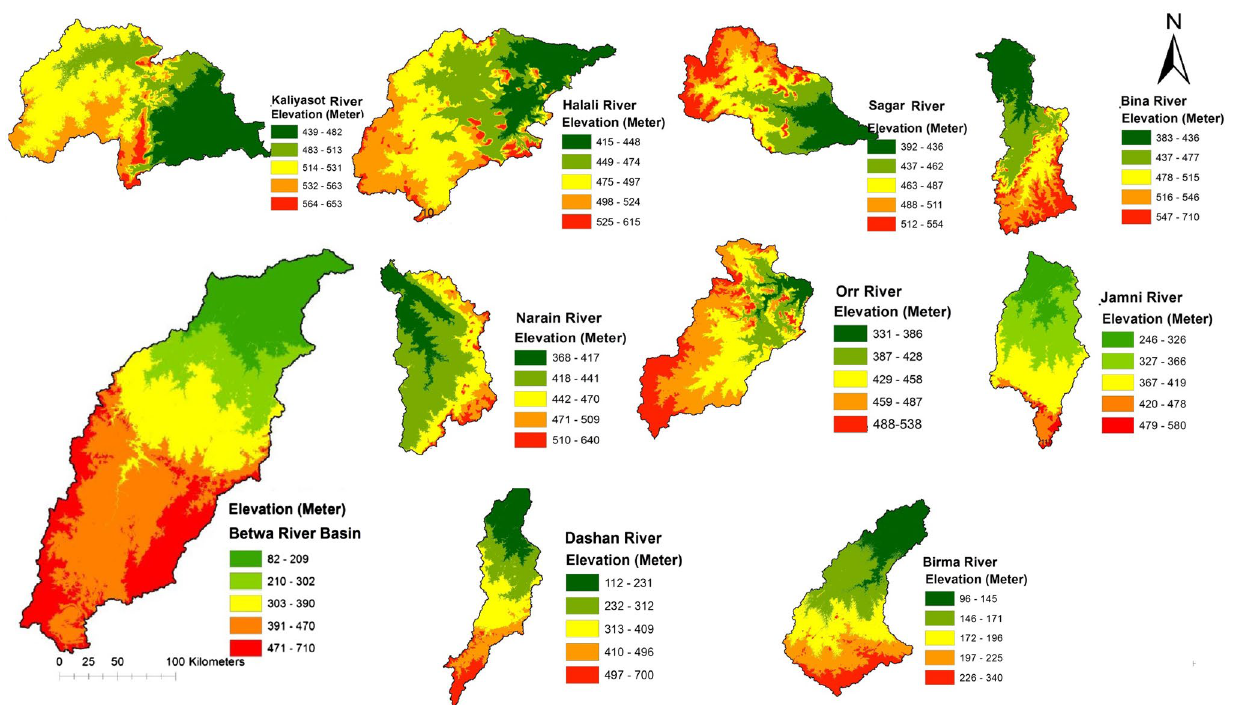
Fig. 5 Elevation map of the Betwa River basin and